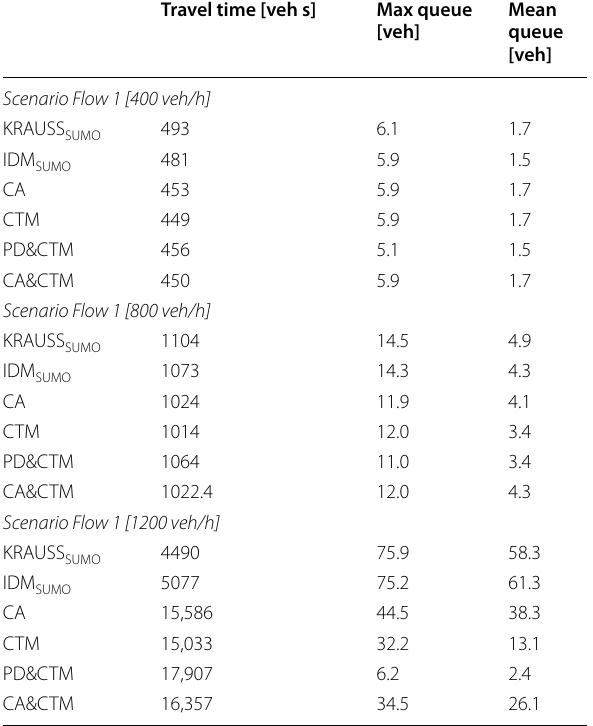
Table 2 Numerical results of the link